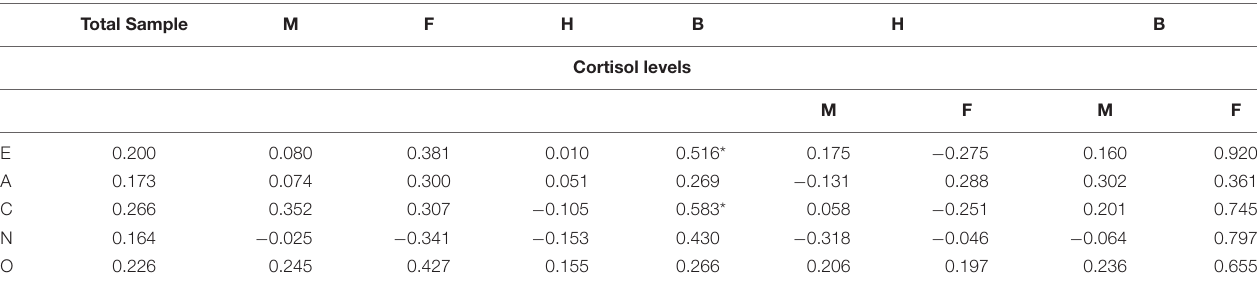
TABLE 2 | Bivariate correlations between personality traits and levels of cortisol in the total sample, sex group, sailing group, and the sailing role within sex groups. Total